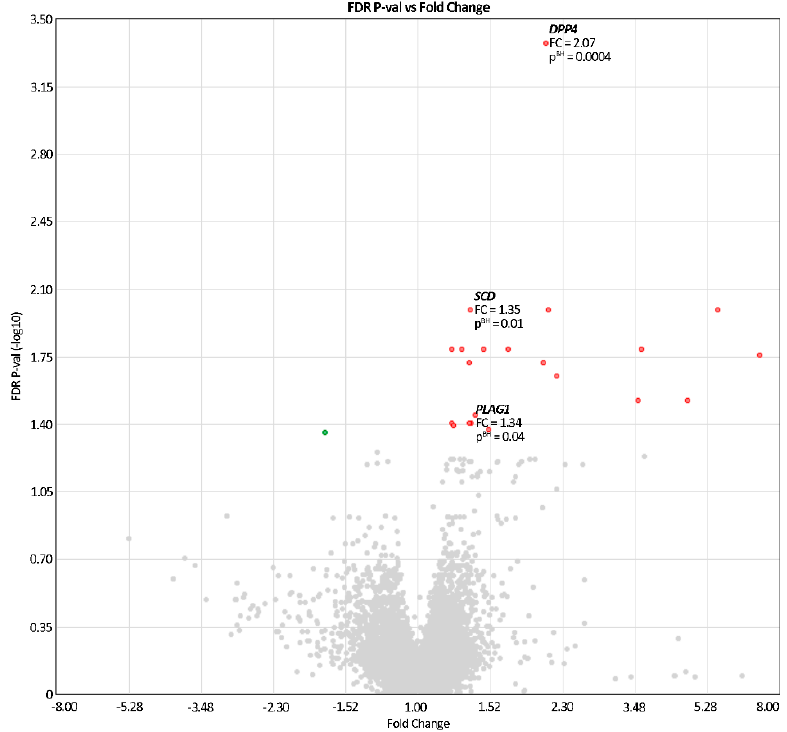
Figure 2. The volcano plot depicting differences in expression of 22 genes with significant expression differences between pre-HSCT and post-HSCT groups (colored dots) and in the whole transcriptome (gray dots).